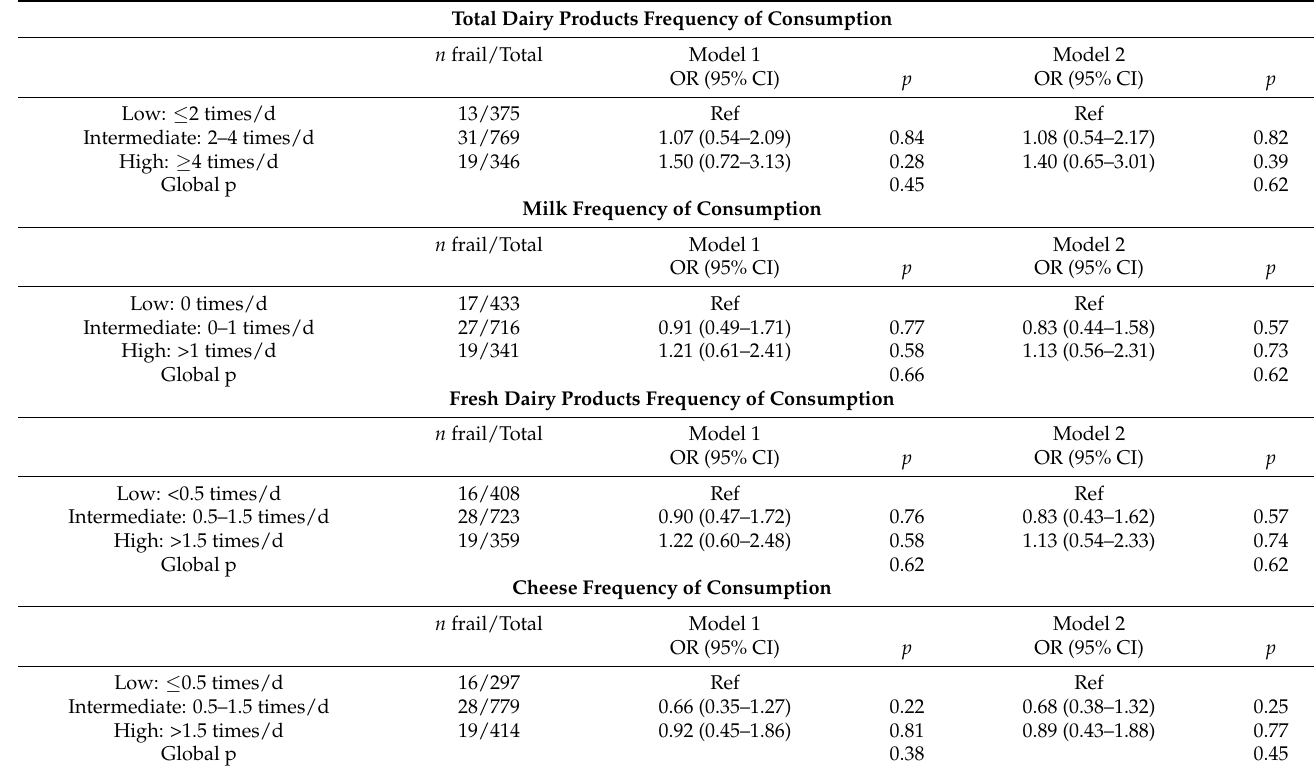
Table 3. Multivariate association between baseline frequencies of consumption of total DP, milk, fresh DP, and cheese and frailty prevalence among older adults in the Three-City Study, Bordeaux ( n = 1490,